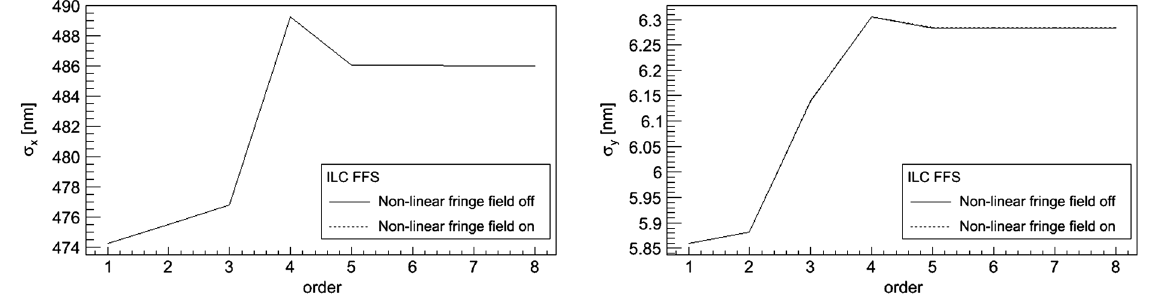
FIG. 10. Nonlinear fringe field impact on the horizontal (left) and vertical (right) beam size in the ILC BDS lattice.